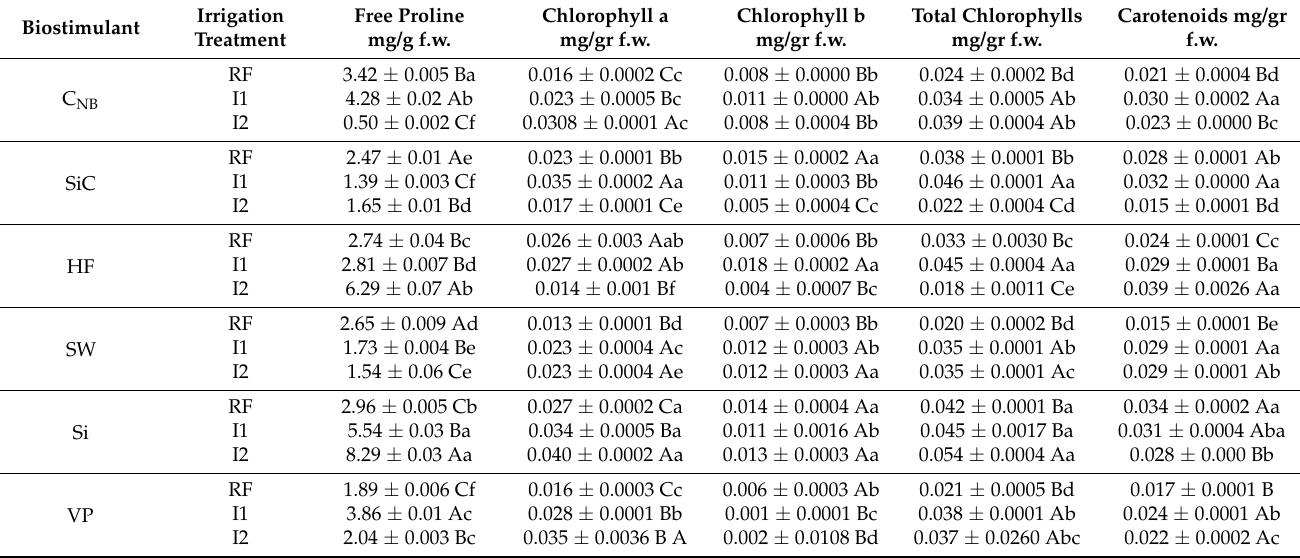
Table 5. Content of free proline, chlorophylls (chlorophyll a, b, and total chlorophylls), and carotenoids of Romaine-type lettuce plants in relation to irrigation regime and biostimulant ap- plication (means ±